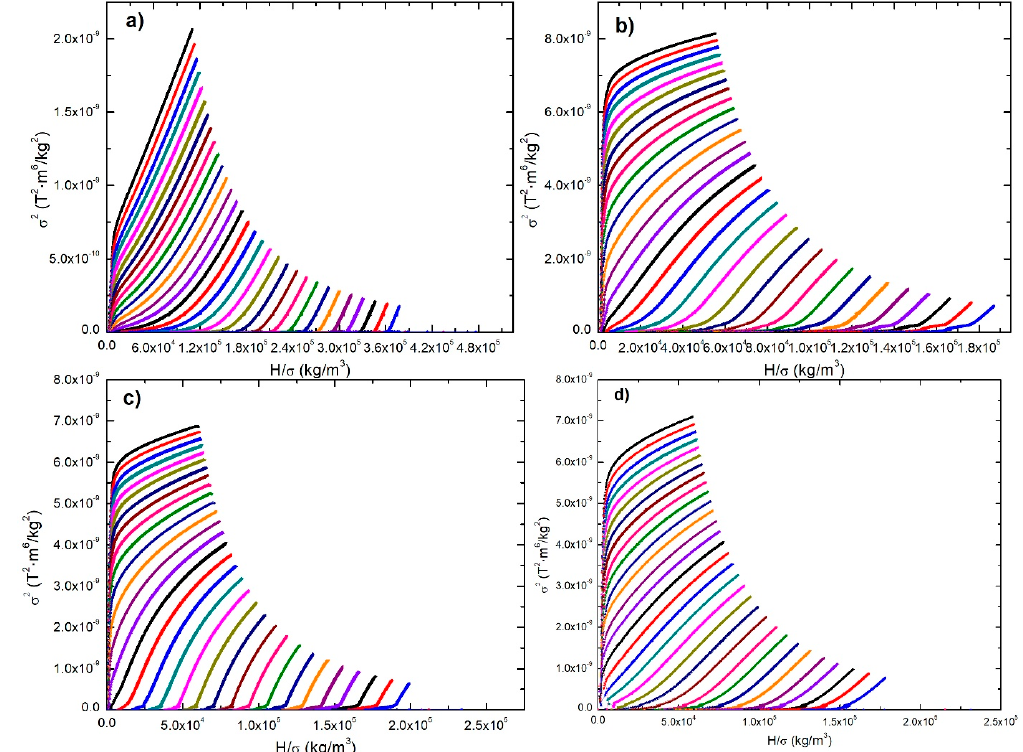
Figure 6. Arrot curves plots ( σ 2 vs H/ σ ) for manganites manufactured by (a) microwave-assisted sol-gel, (b) Pechini sol-gel, (c) solid-state reaction with planetary mill, and (d) solid-state reaction with attritor mill.